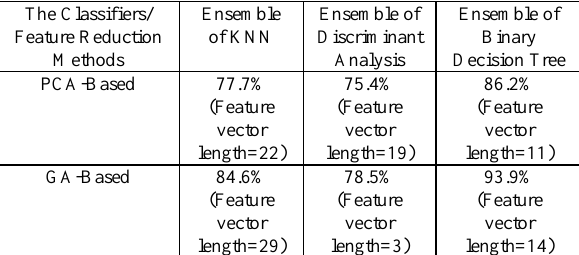
Table 2. The final feature vector lengths and the obtained classification accuracies